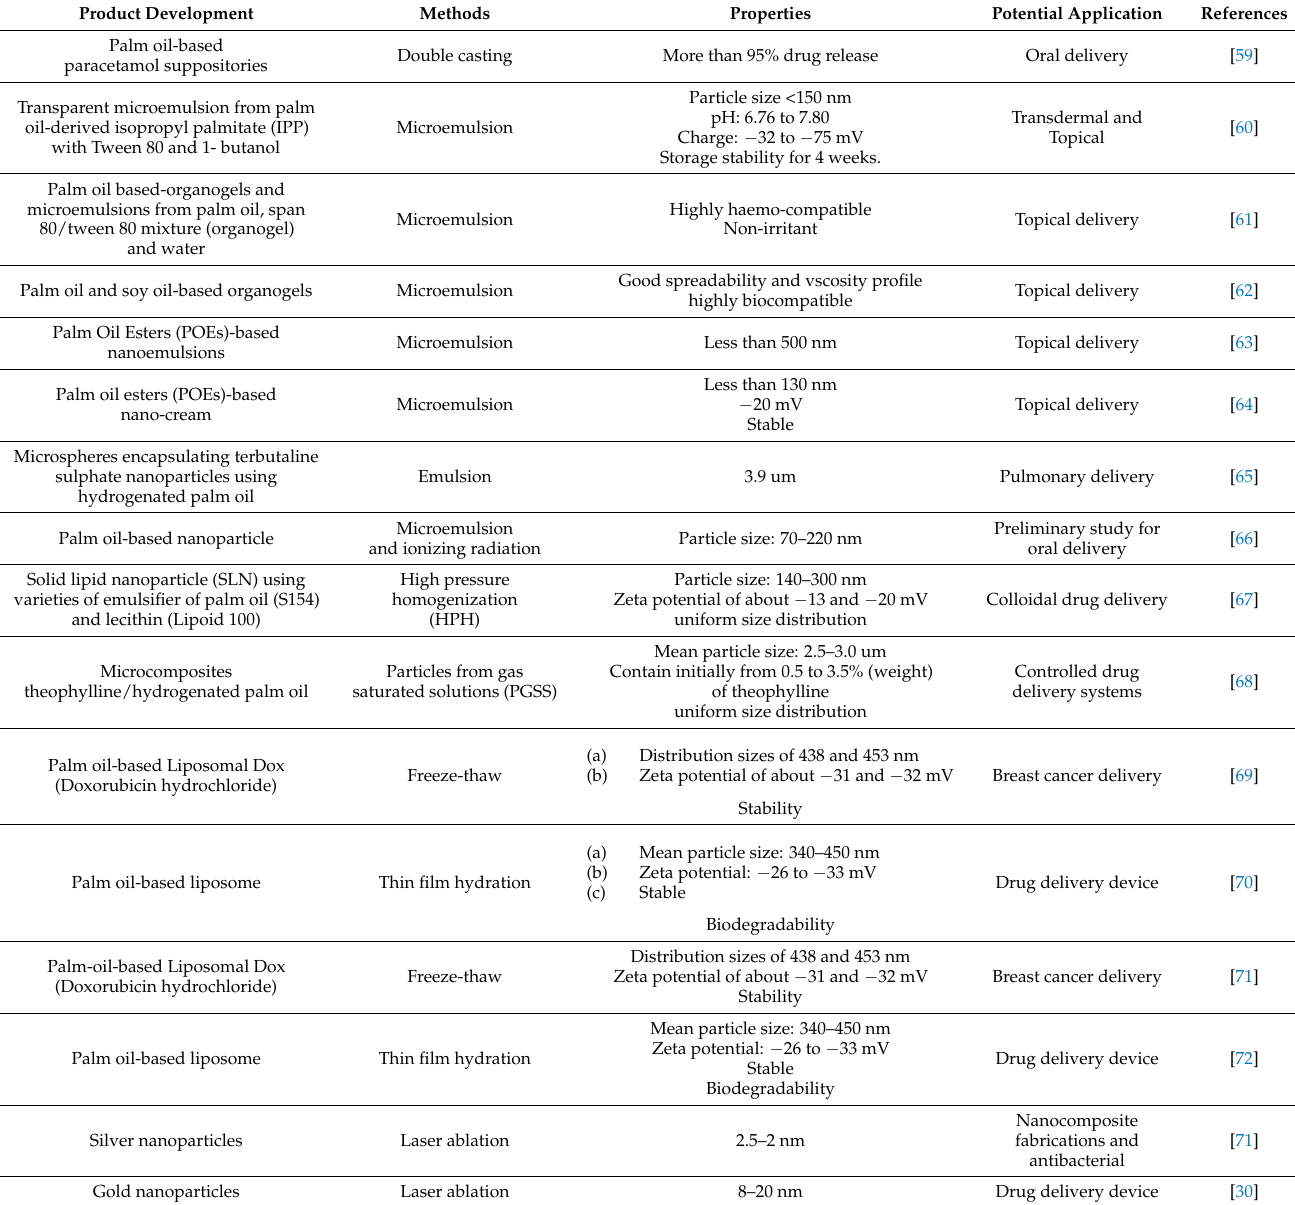
Table 3. Current development of palm oil-based products in drug